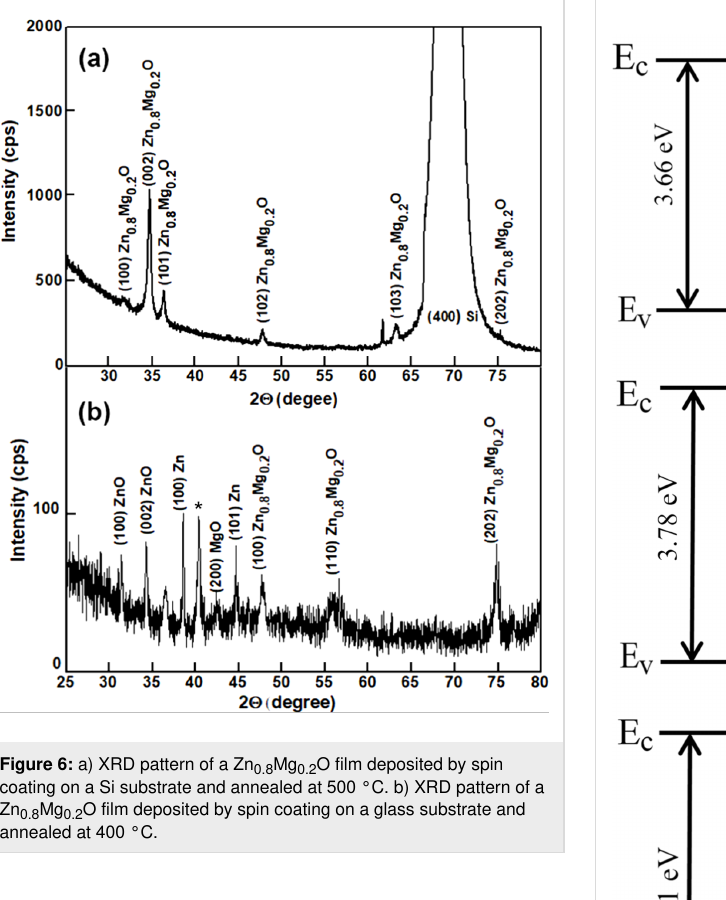
Table 3: The summarized PL band maximum in Zn 1 − x Mg x O films.